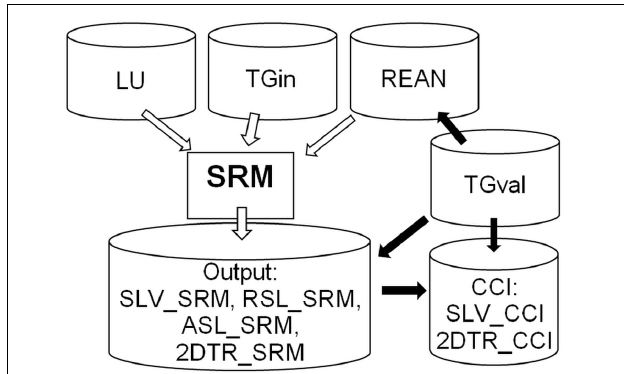
FIGURE 1 | Conceptual chart of model and data flows. SRM, statistical reconstruction model; REAN, reanalysis model data; CCI, CCI satellite altimetry product; LU, land uplift model data; TG, tide gauge data (for input and for validation); SLV, sea level variability; RSL, relative sea level; ASL, absolute sea level; 2DTR, 2D-trends; white arrows, data flow for the SRM; black arrows, validation.